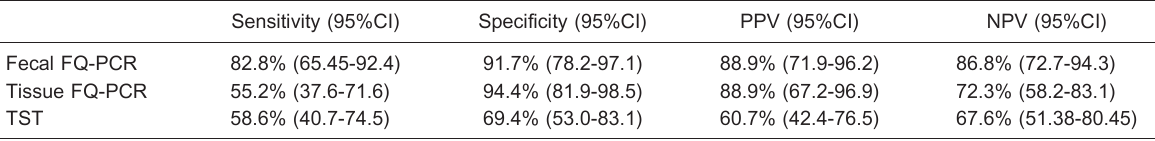
Table 3. Clinical evaluation of fecal FQ-PCR, tissue FQ-PCR and